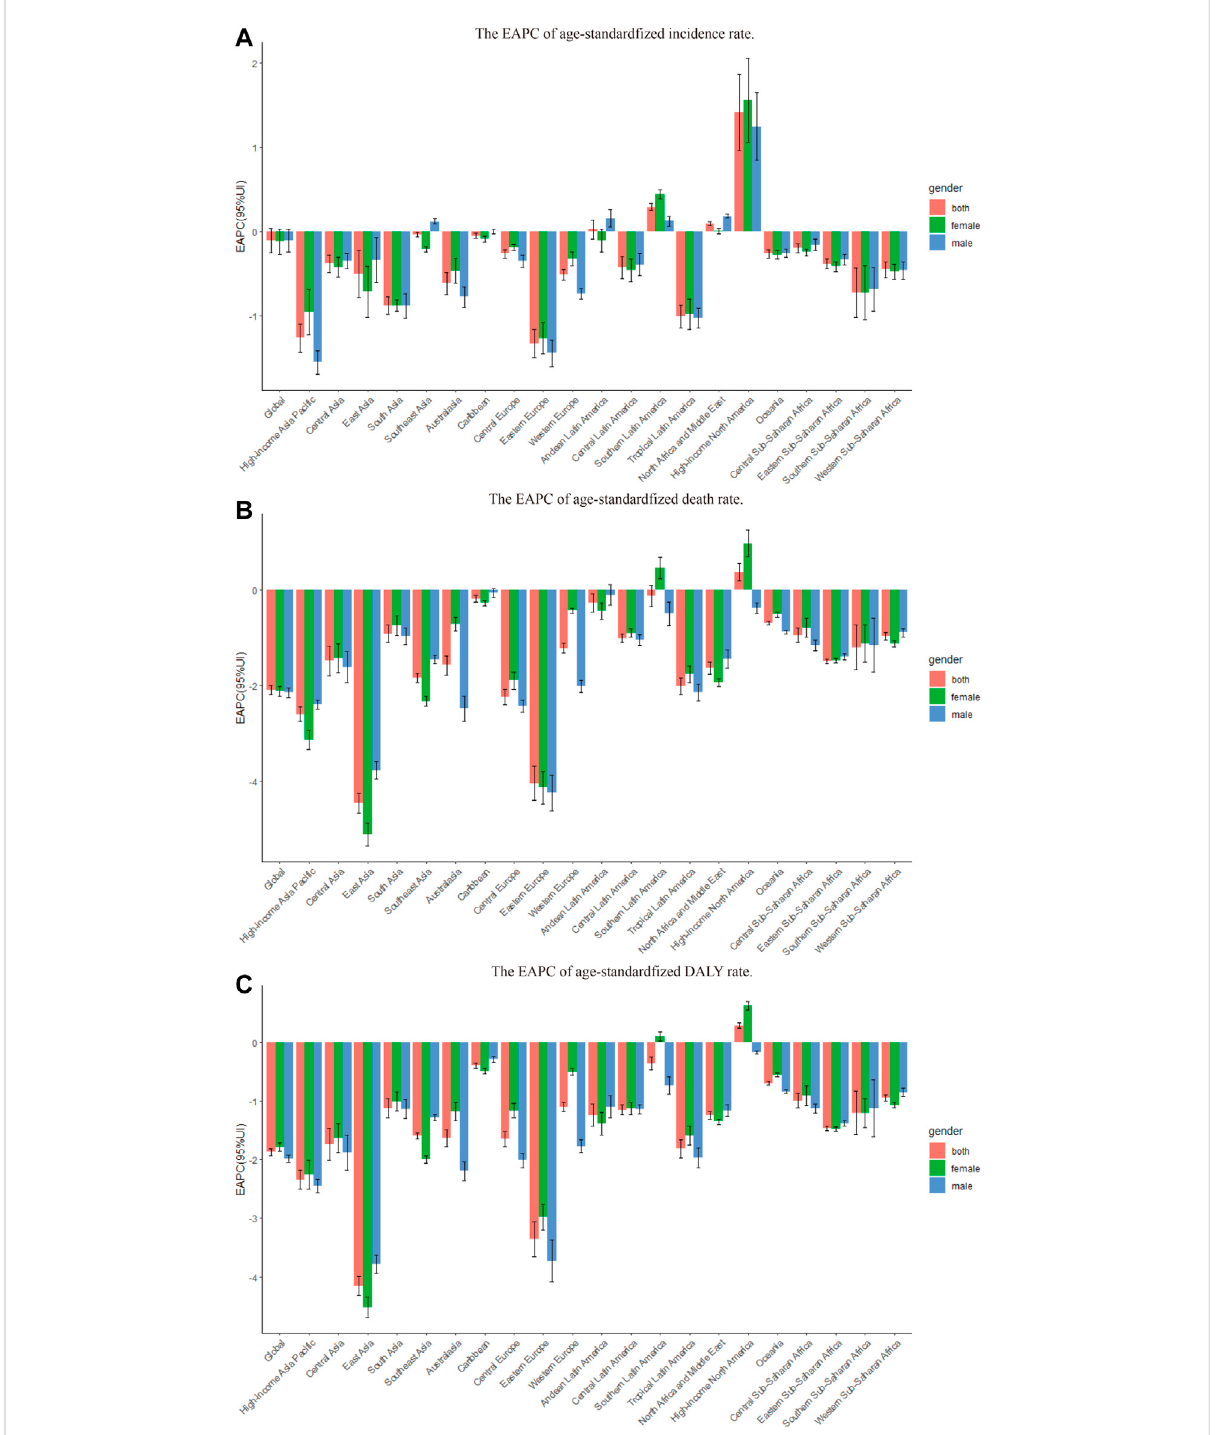
FIGURE 1 The EAPC of chronic obstructive pulmonary disease age-standardized rates from 1990 to 2019, by gender and region. (A) The EAPC of age- standardized incidence rate. (B) The EAPC of age standardized death rate. (C) The EAPC of age-standardized DALY rate. EAPC = estimated annual percentage change. DALY = disability adjusted